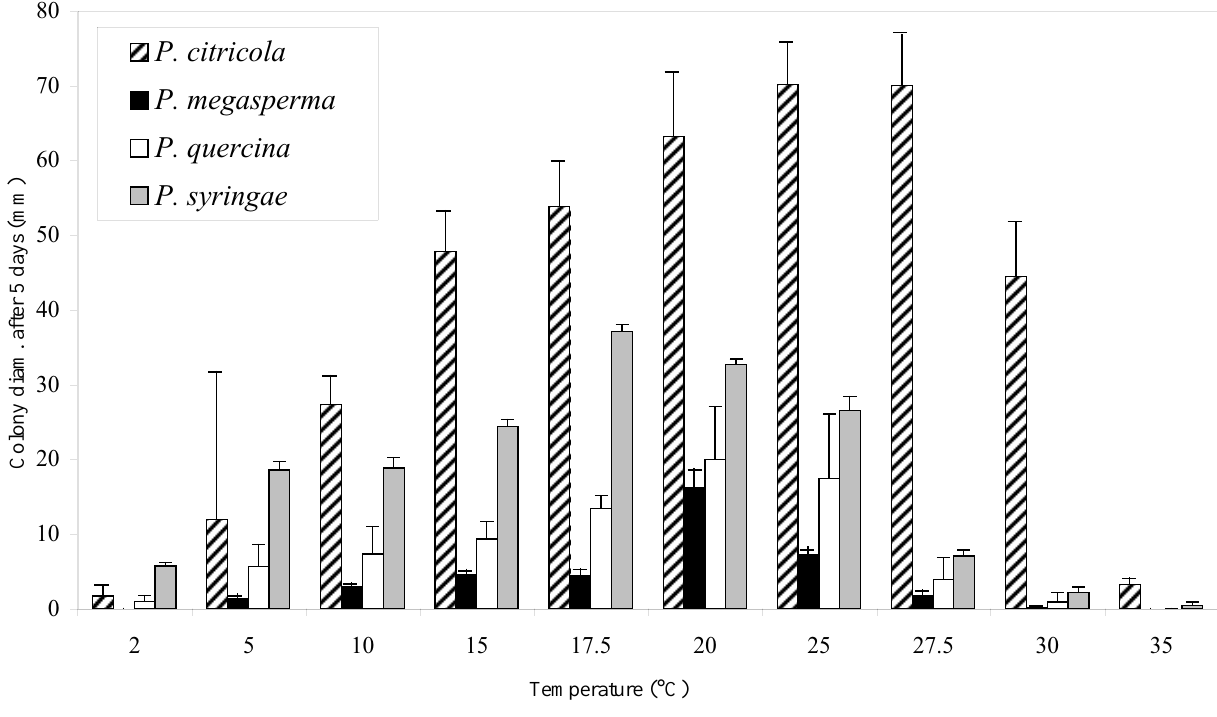
Fig. 2. Growth of Phytophthora isolates at various temperatures on V8